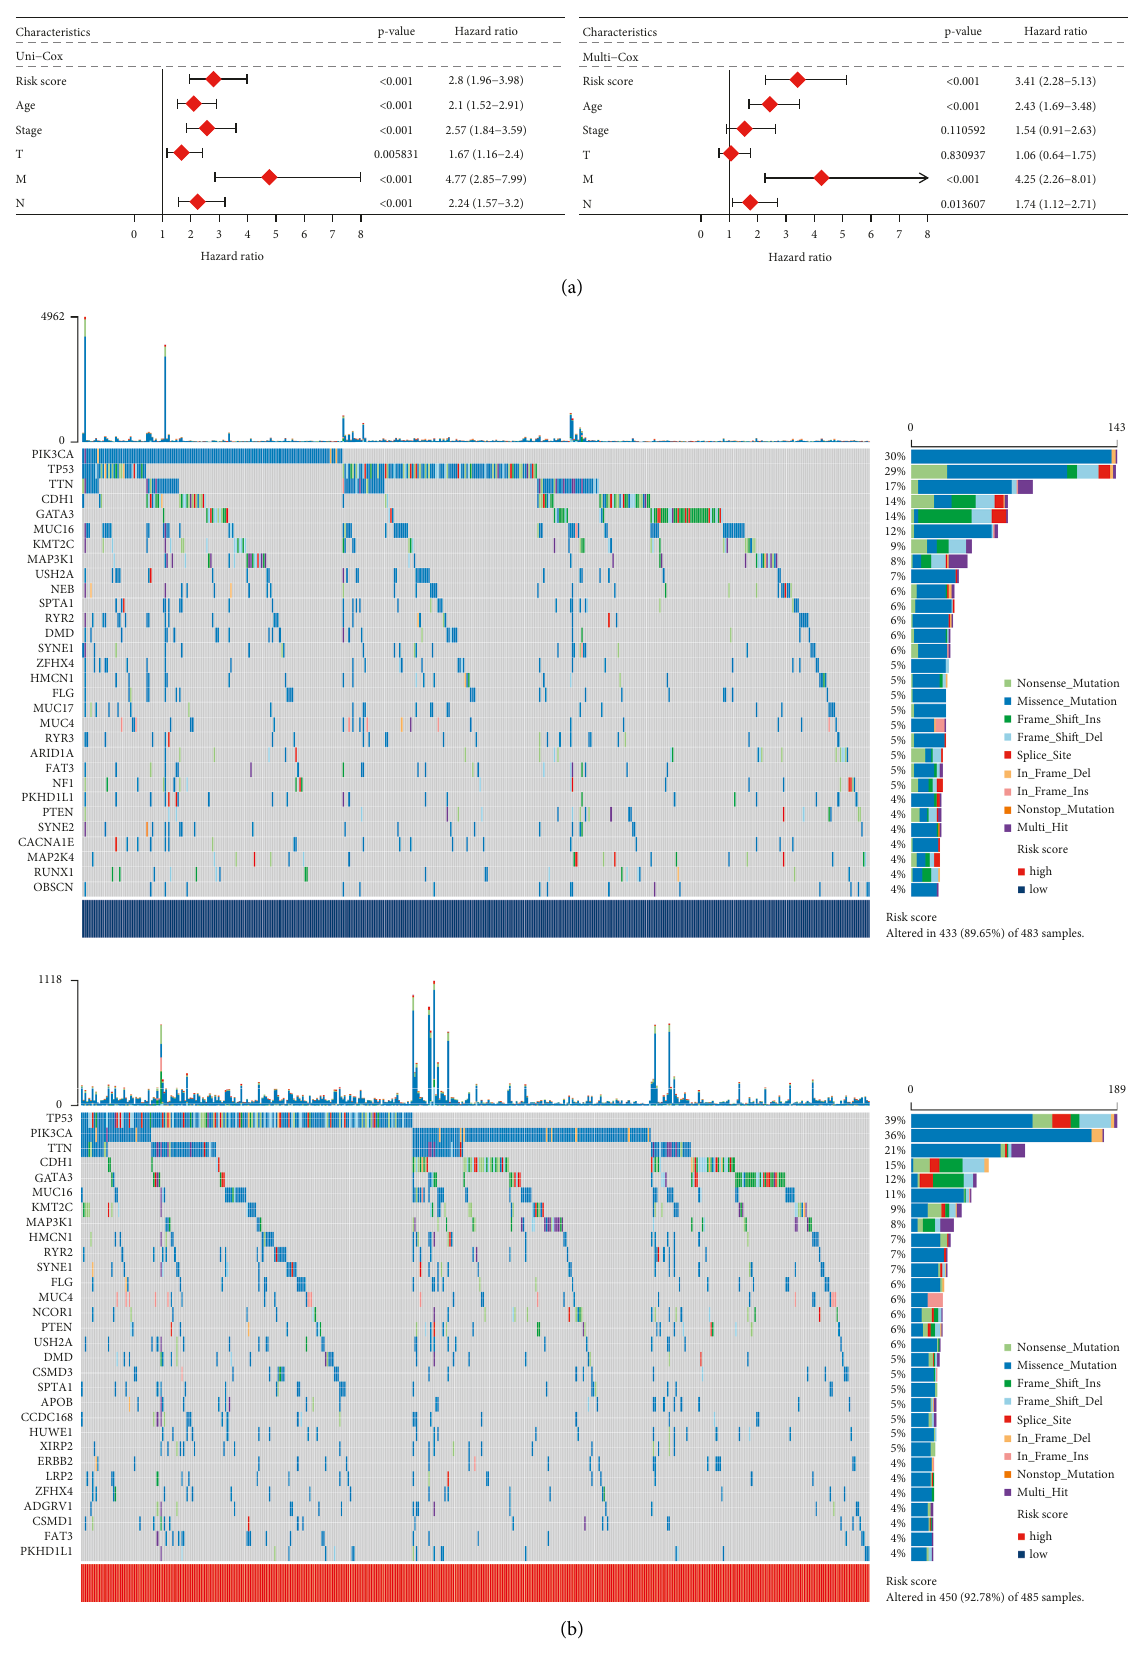
Figure 3: Univariate, multivariate, and mutation analyses of the different risk score groups. (a) Univariate and multivariate Cox analyses of the risk scores and the clinical characteristics of the patients. (b) Mutation patterns of mitochondria-related genes from different risk score